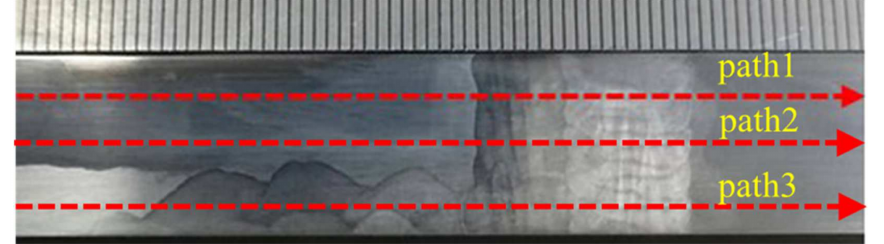
Figure 13. Three paths defined along the neutron scan lines (refer to Figure 4) across the DMW joint for residual stress evaluation and comparison.